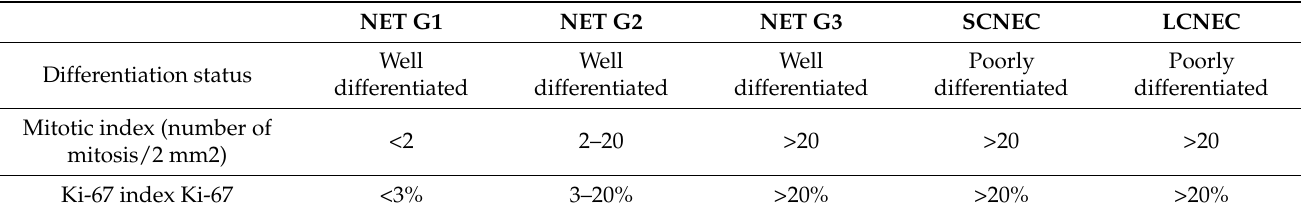
Table 2. Classification of digestive NENs (2019) [8].